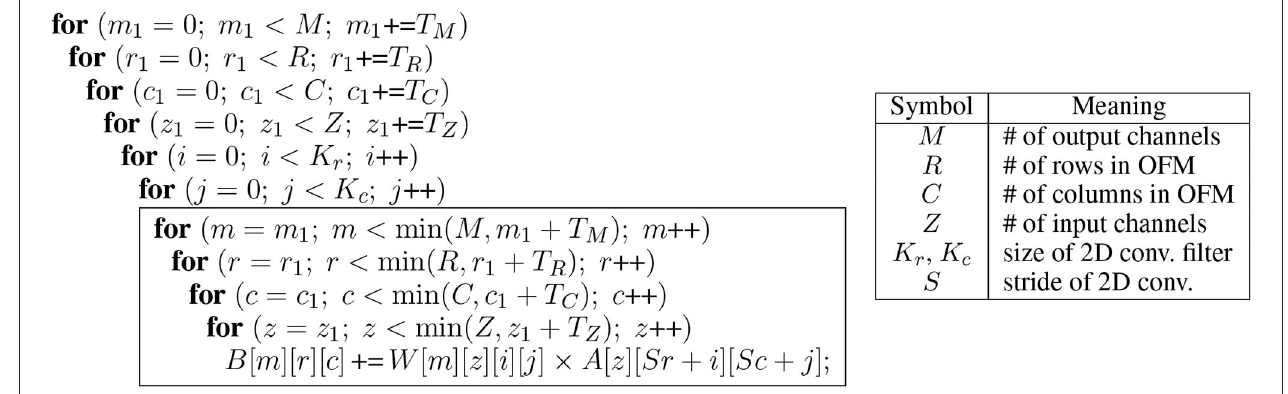
FIGURE 5 | Convolution layer tiled along four loop levels ( M , R , C , Z ). Arrays A , B , and W are input feature map (IFM), output feature map (OFM), and weight parameters, respectively. The four innermost loops are hardware-unrolled, creating a 4D-parallel architecture.